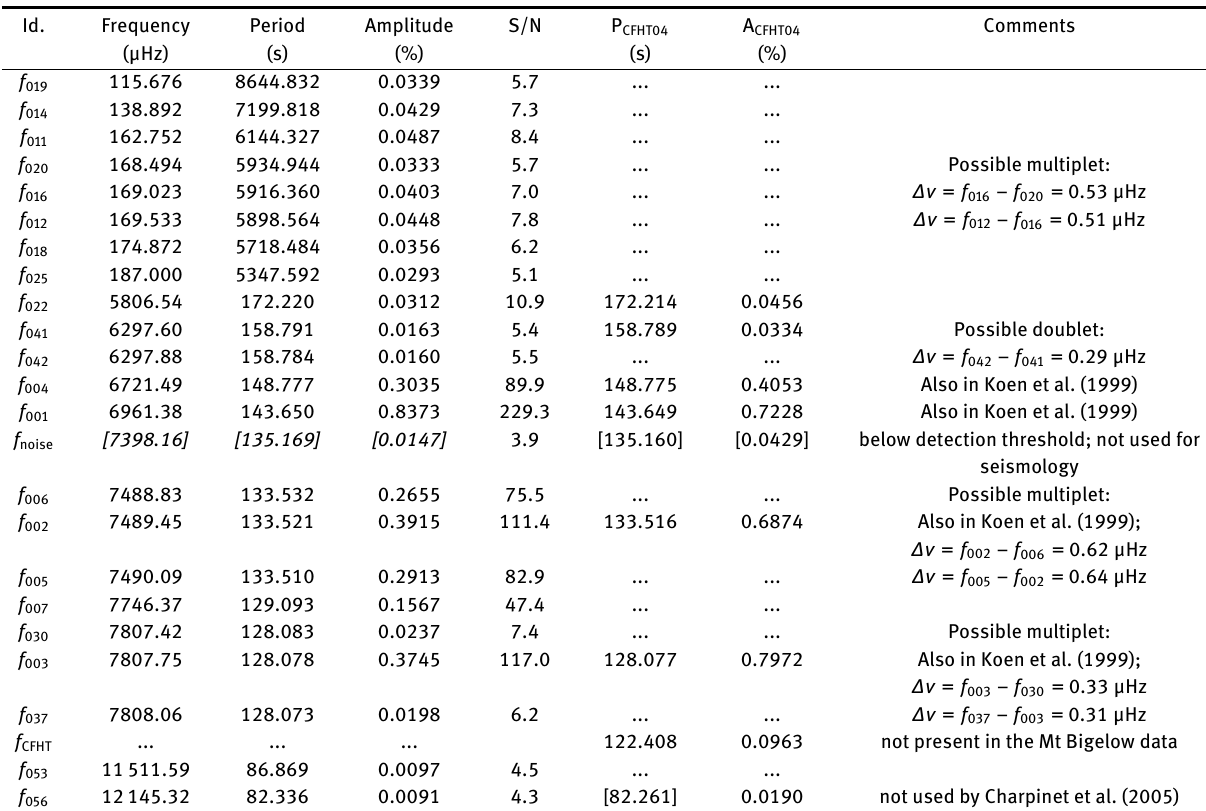
Table 1. List of oscillation modes from the combined light curve of PG 1219+534 obtained in Mt Bigelow that will be used in our asteroseis- mic modeling. The oscillation modes detected at CFHT and used by Charpinet et al. (2005) are also listed, as well as those of the discovery campaign of Koen et al.